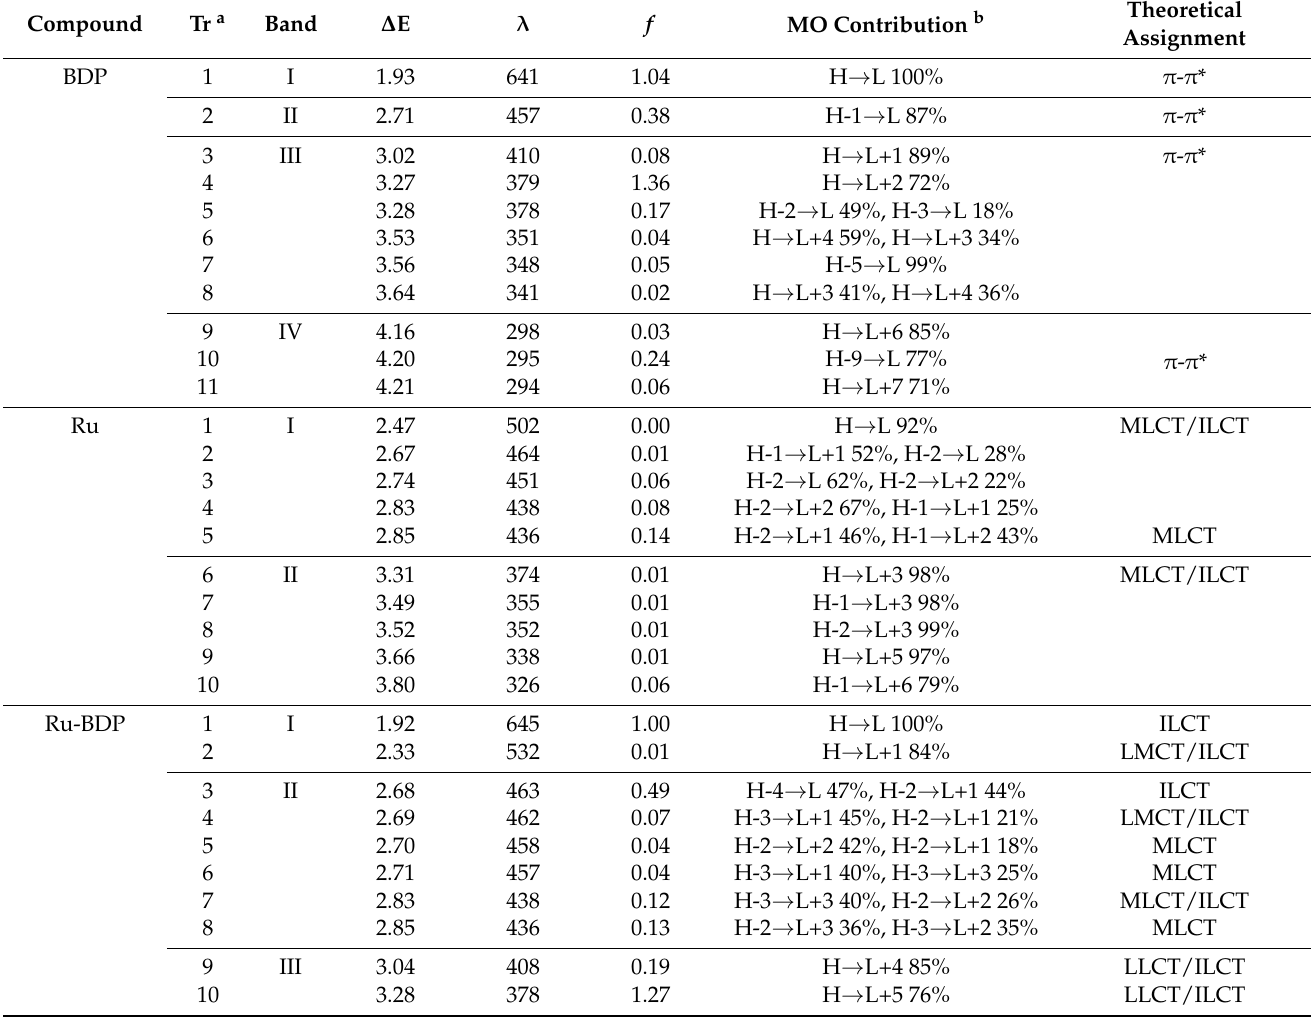
Table 1. Excitation energies ( ∆ E, eV), absorption wavelength ( λ , nm), oscillator strength ( f ), MO contribution (%) for selected transitions (Tr) of BDP, Ru and Ru-BDP